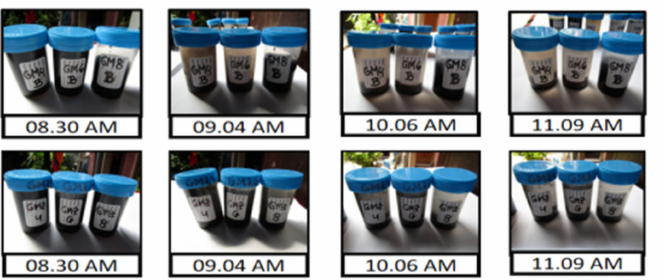
Figure 15. Colloid stability of CNS from pyrolysis of the rice husk (G) without ZnCl 2 (without Z) and ZnO/CNS from pyrolysis of rice husk (G) with ZnCl 2 (with Z).